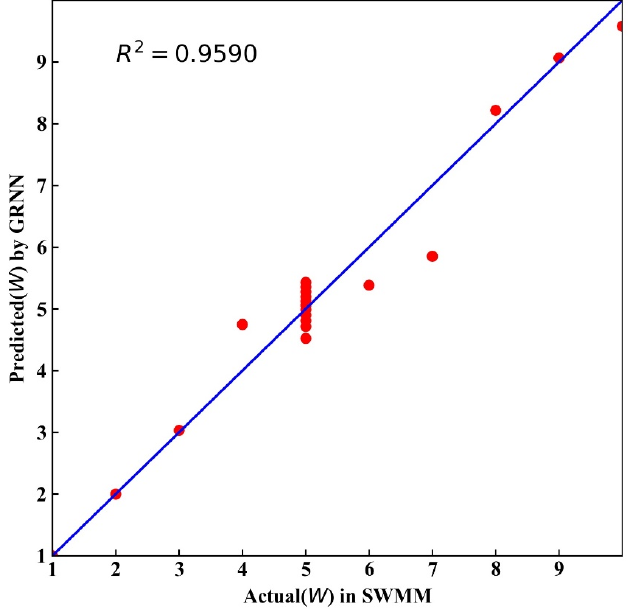
Figure 7. Relationship between actual width (W) and predicted W values.